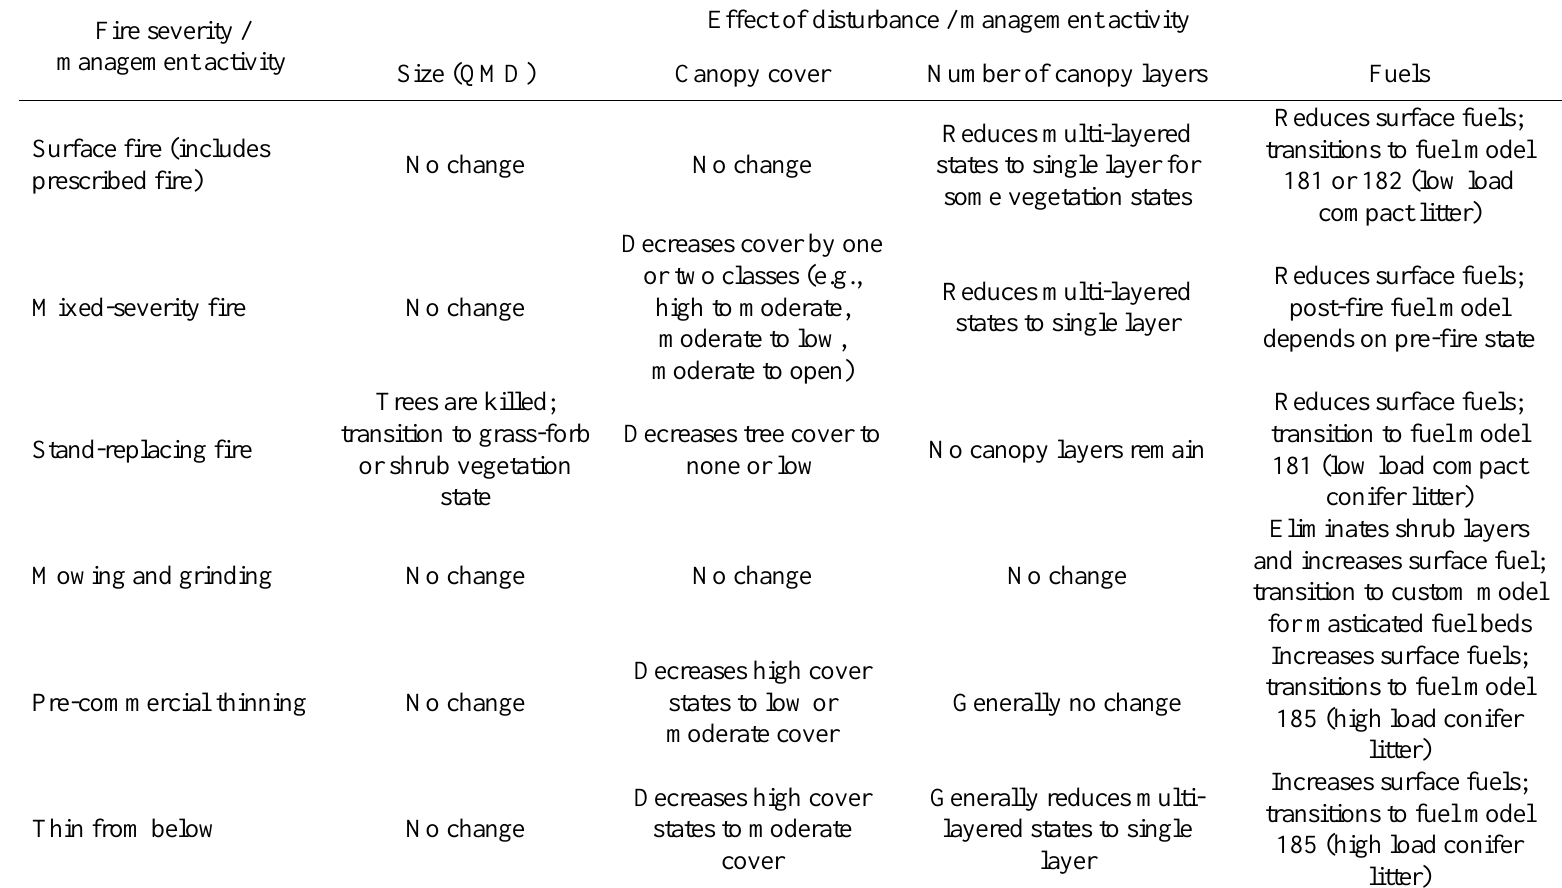
Table A4.1. Effect of fire severity and management on average tree size, canopy cover, layering, and fuels in state-transition vegetation classes. QMD = quadratic mean